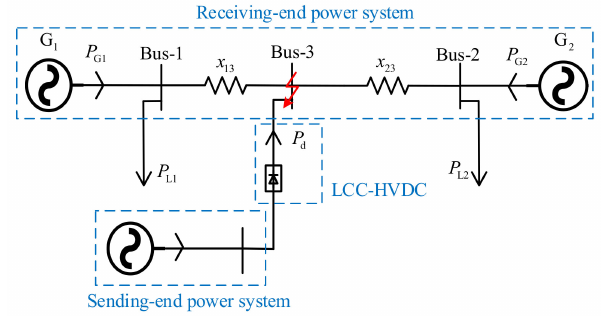
Figure 2. Equivalent model of the receiving-end power